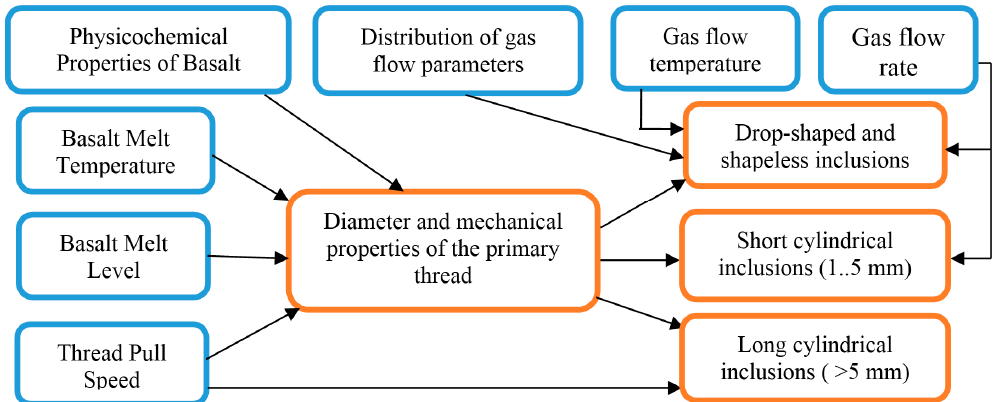
Figure 2. The influence of the physical parameters of the technological process on the formation of non-fibrous inclusions.